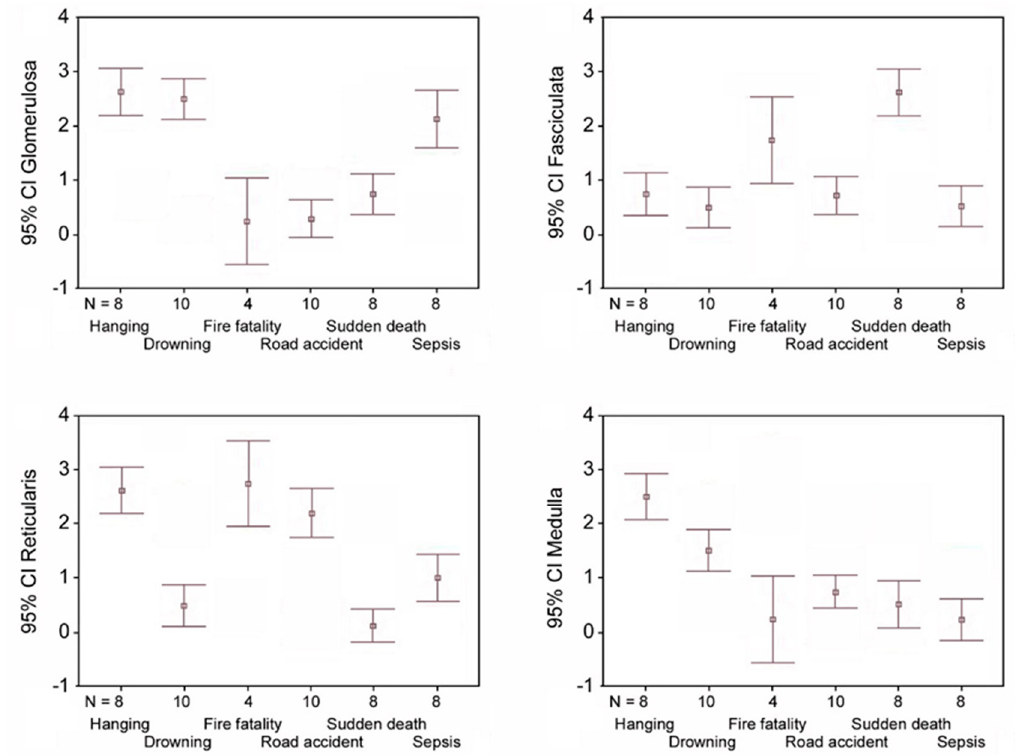
Figure 3. Error bar graphs show mean value and relative 95% confidence interval (CI) of β 2-AR expression of each adrenal zone (glomerulosa, fasciculata, reticularis, medulla) in the different causes of death examined.